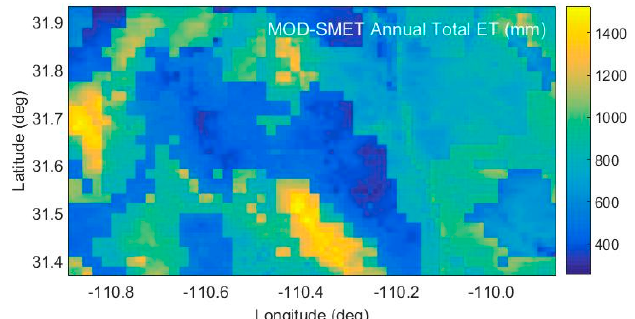
Figure 2. MODis-Soil Moisture ET (MOD-SMET) estimated cumulative actual evapotranspiration (mm) for the year 2013 (top) and land cover classification from NLCD [40] for the same region.